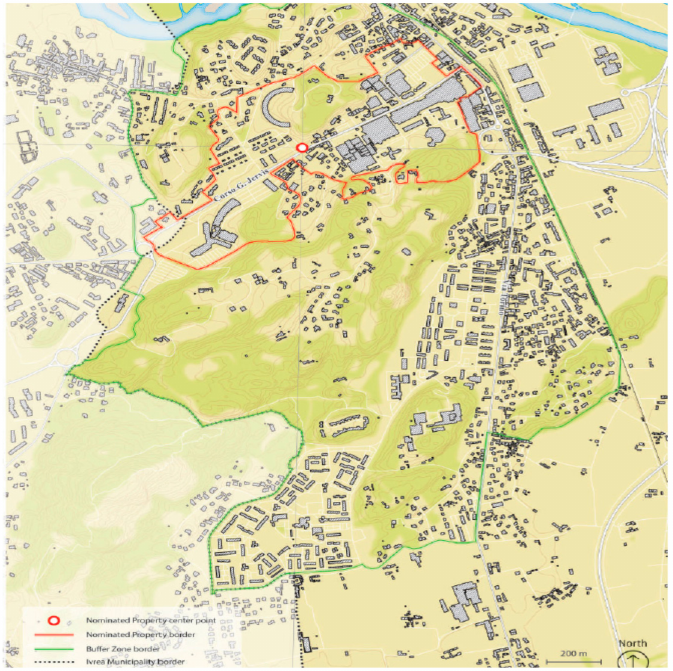
Figure 1. Delimitation of the nominated property and buffer zone (source: Nomination File, p.